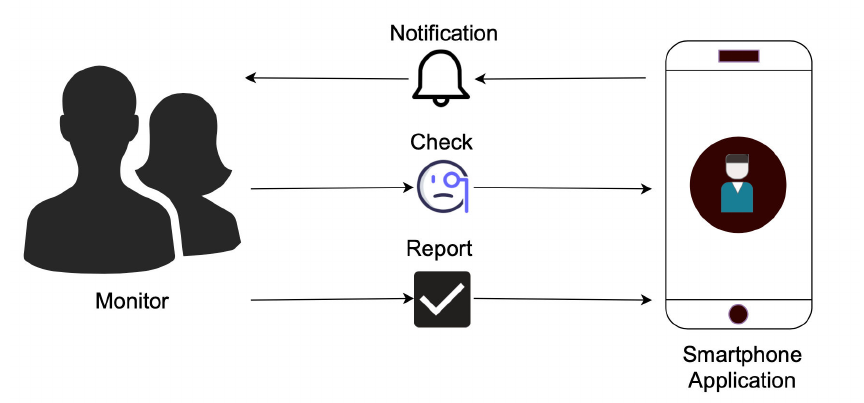
Figure 2. Interaction between Monitor and smartphone application.